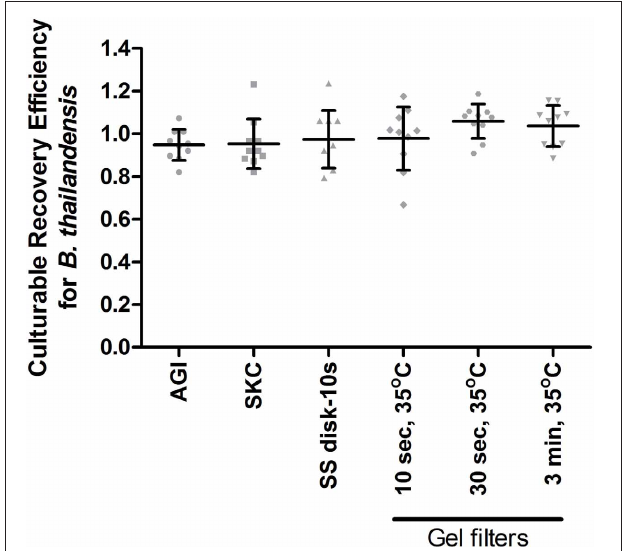
FIGURE 4 | Culturable recovery efficiency of B. thailandensis . The culturable recovery efficiency of B. thailandensis from any of the sampling media and recovery processes tested were not significantly different from one another ( P = 0 . 1569); lines represent the mean, and ± one standard deviation; n = 10 for each jar